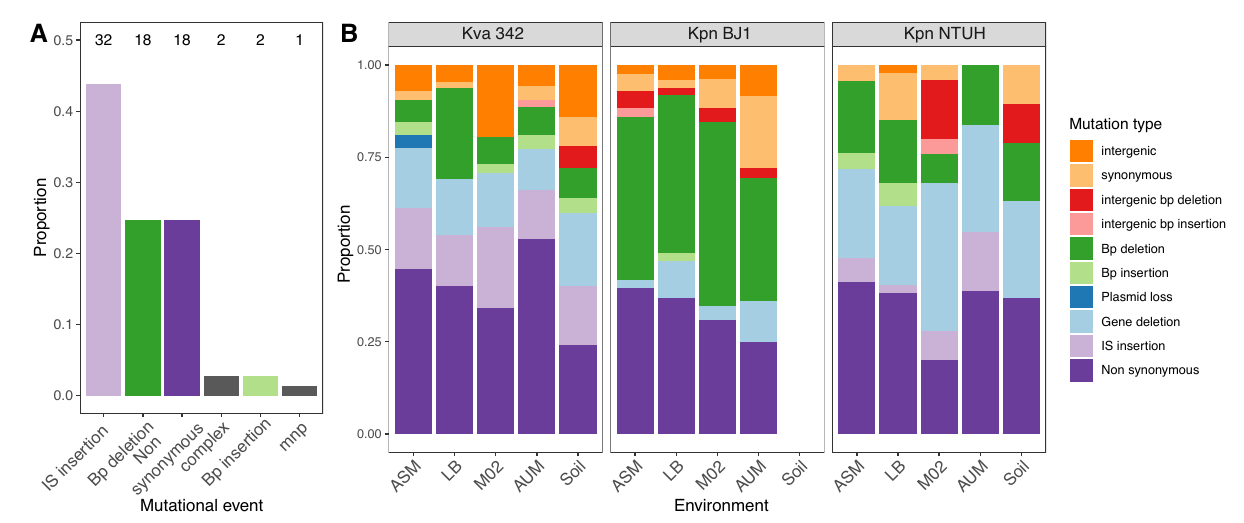
Fig. 4 | Mechanisms of mutations in evolution experiments of Klebsiella . A . Type of mutations observed in the capsule operon of 73 independent non- capsulated clones descending from capsulated ancestors after 20 generations (end-point) in the short evolution experiment in well-mixed environments. The number on top of the bars indicates how many clones per category. Mnp multiple